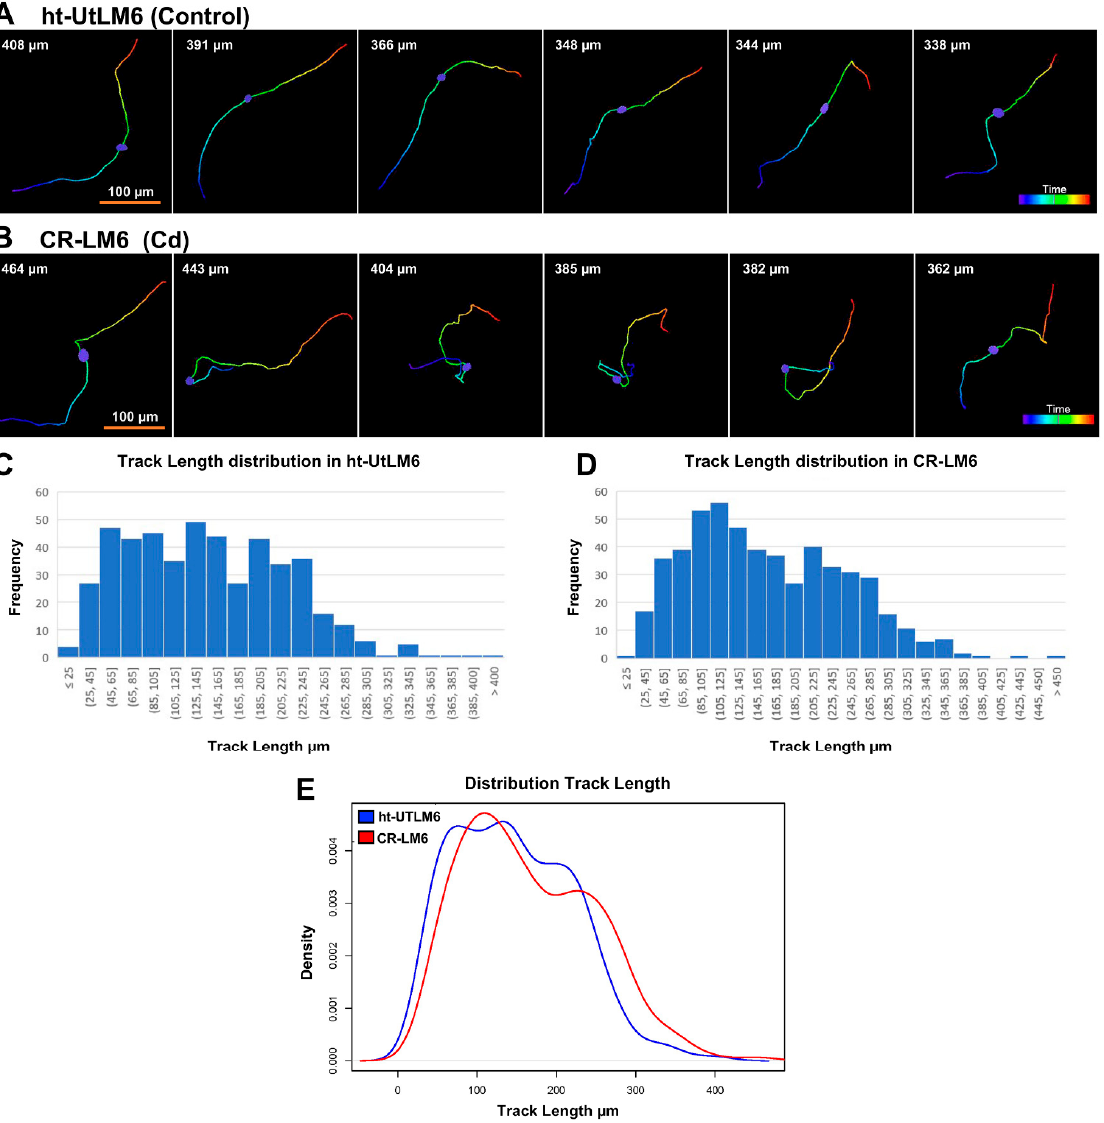
Figure 3. Track Length analysis. ( A ) The full track displays for the top 6 longest tracks. The Track Length values calculated by Imaris are displayed at the top-left. A. ht-UtLM6 tracks were relatively smooth and straight. ( B ) CR-LM6 tracks had sharp turns and sometimes loops. Scale bar = 100 µm. ( C , D ). The histograms of Track Length distribution for ht-UtLM6 and CR-LM6. ( E ) The probability density function curves of Track Length for the two